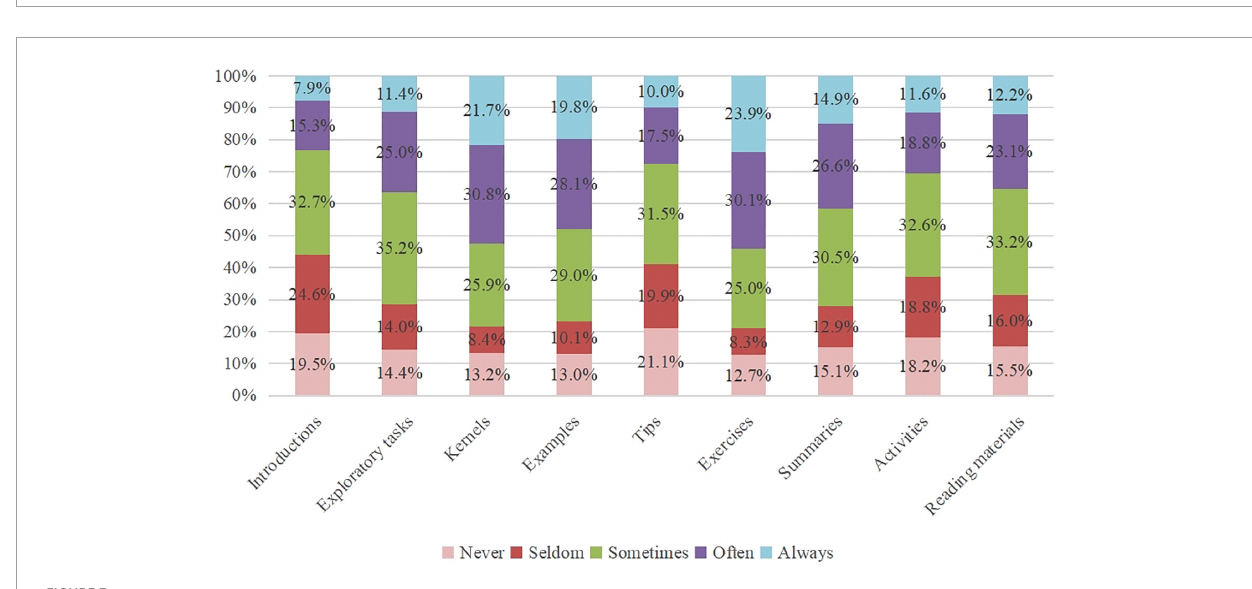
FIGURE2 Percentage distributions of the frequency of textbook use at different timing.